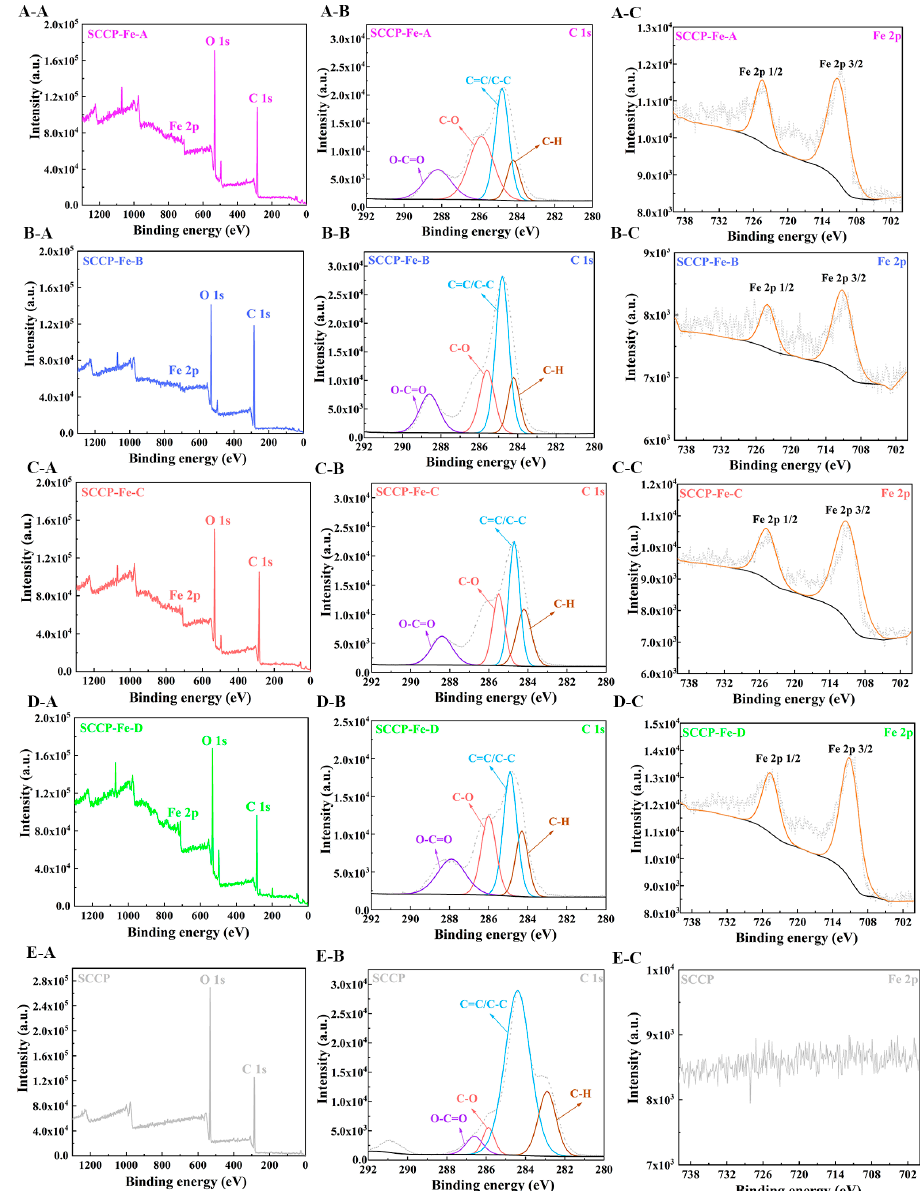
Figure 3. XPS analysis of four sweet corn cob polysaccharide-iron (III) complexes (( A-A ) XPS spectra of the total elements; ( A-B ) C 1s; ( A-C ) Fe 2p, in SCCP-Fe-A; ( B-A ) XPS spectra of the total elements; ( B-B ) C 1s; ( B-C ) Fe 2p, in SCCP-Fe-B; ( C-A ) XPS spectra of the total elements; ( C-B ) C 1s; ( C-C ) Fe 2p, in SCCP-Fe-C; ( D-A ) XPS spectra of the total elements; ( D-B ) C 1s; ( D-C ) Fe 2p, in SCCP-Fe-D; ( E-A ) XPS spectra of the total elements; ( E-B ) C 1s, ( E-C ) Fe 2p, in SCCP).